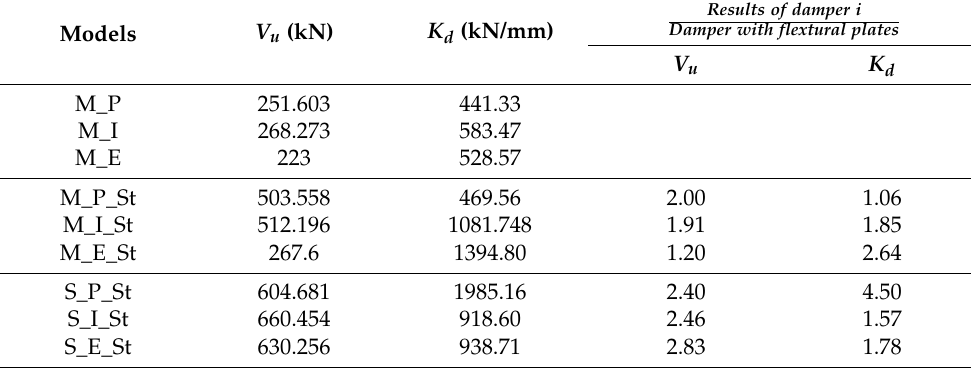
Figure 12. The yielding of all dampers. Table 4. Ultimate strength and elastic stiffness of the